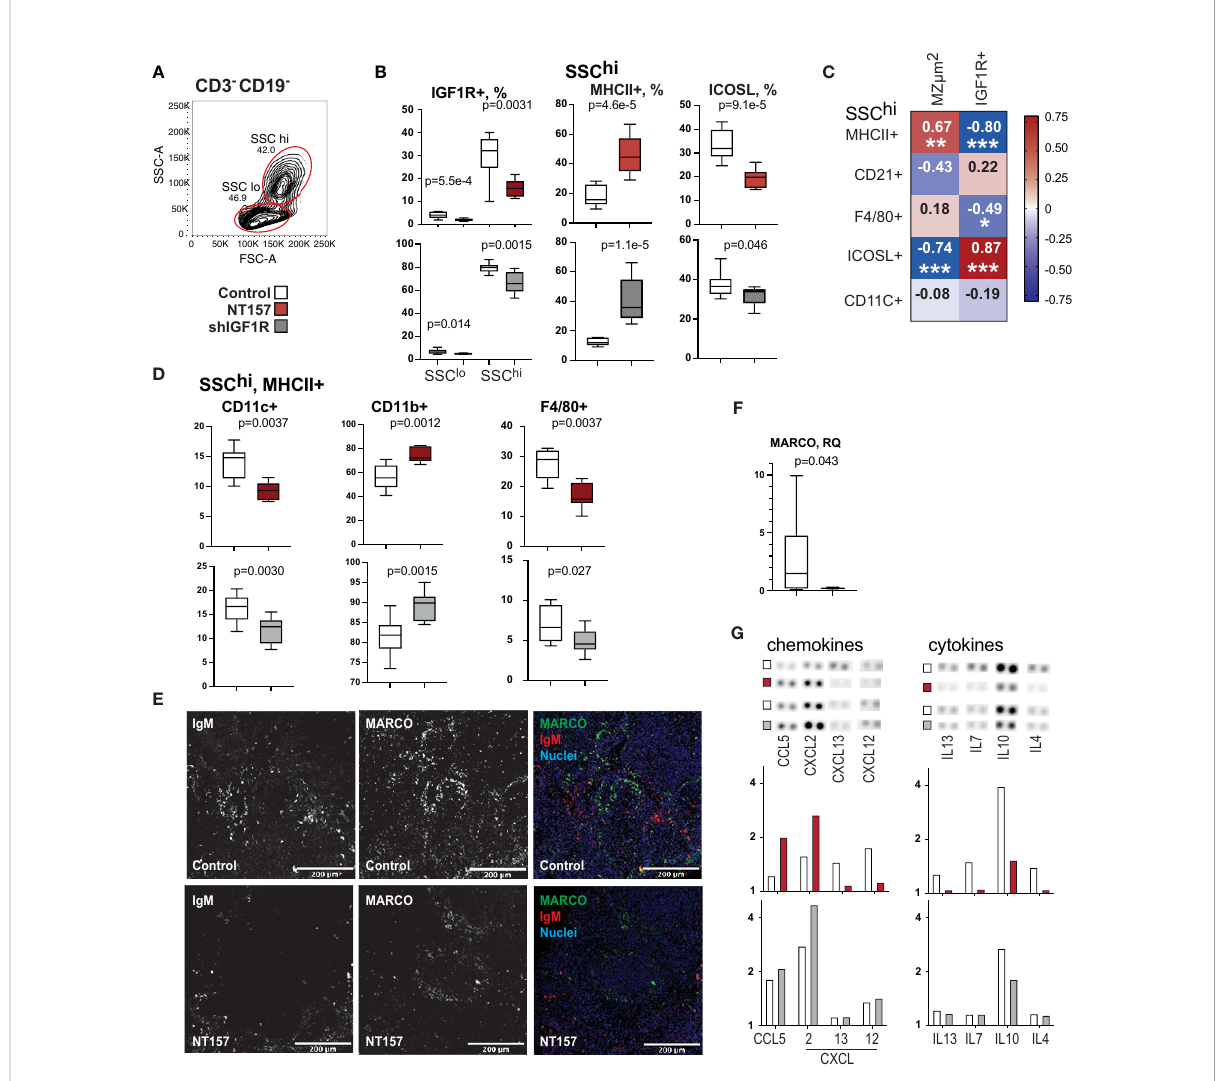
FIGURE 2 Phenotype and function of antigen presenting cells after inhibition of IGF1R signalling. (A) Flow cytometry gating strategy for large granular CD3-CD19- (SSC hi ) cells by forward scatter (FSC) and side scatter (SSC). (B) Box plots of IGF1R+ subset in SSC hi cells in NT157 and shIGF1R- treated mice. SSC hi cells in NT157 (upper row) and shIGF1R (lower row) treated mice by MHCII, ICOSL, CD11b and CD11c. (C) Correlation heatmap between SSChi populations and MZ area and IGF1R+ cells. Spearman correlation was applied. (D) Box plots of CD11c +, CD11b + and F4/ 80 + subsets of SSC hi MHCII + cells. (E) Confocal image of IgM and MACRO staining in spleen of control and NT157 treated mice. (F) Box plot of mRNA levels of MACRO in spleen of NT157-treated and control mice. (G) Dot blot array of chemokine and cytokine levels in supernatants of LPS-stimulated spleen cell cultures of NT157-treated and control, and shIGF1R-treated and control mice. *p<0.05, **p<0.01,